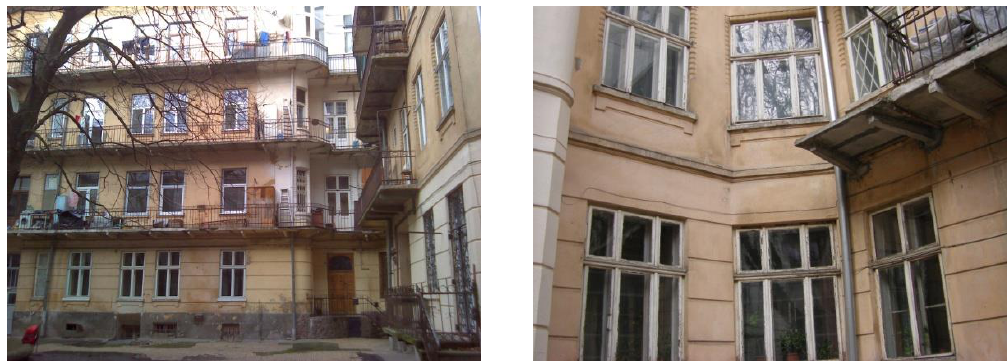
Figure 3. Internal Figure 3. Internal courtyard. Figure 3. Internal courtyard.